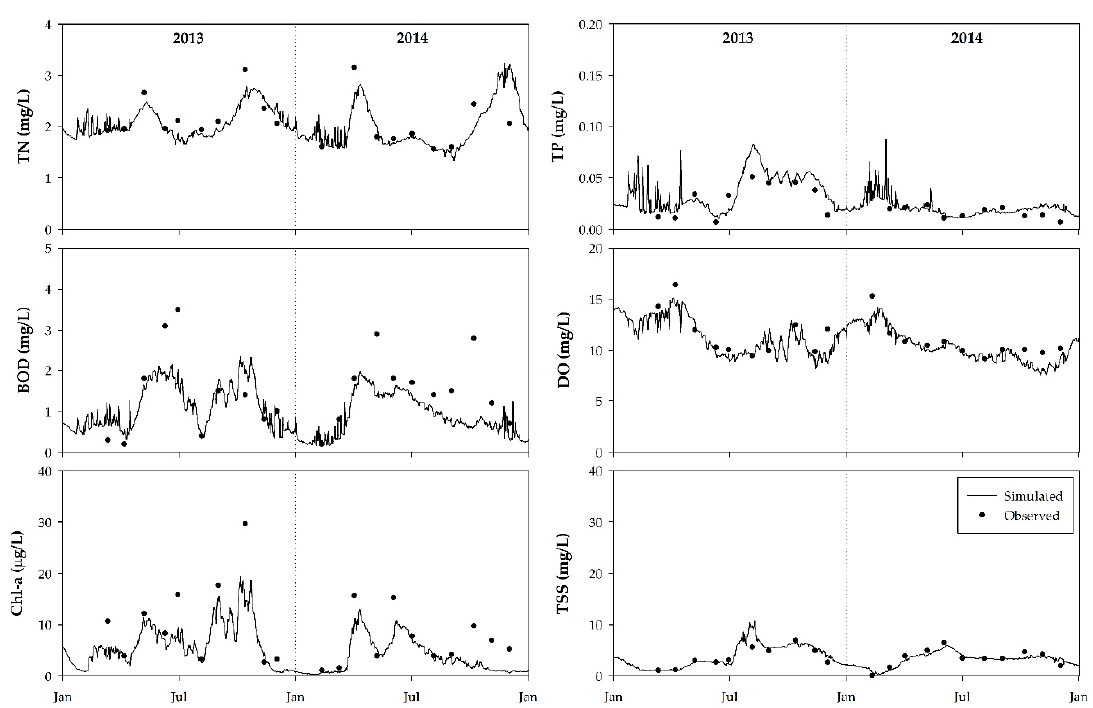
Figure 7. Comparison of observed and simulated water quality for calibration (2013) and verification (2014) at St. 3.